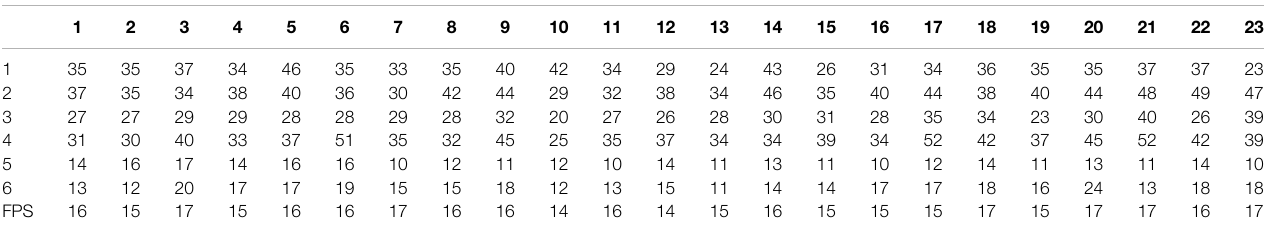
TABLE 2 | Example of vehicle count statistics in each lane from 7 to 9 a.m., 1 June